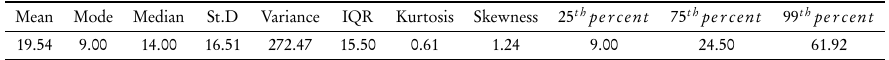
Descriptive statistics for the vehicle fatalities